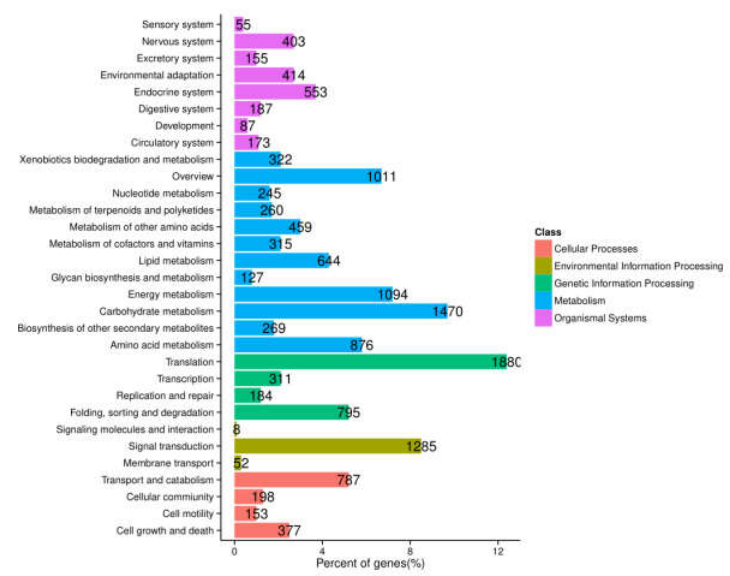
Figure 2. Gene ontology classification of A. megalophylla unigenes.